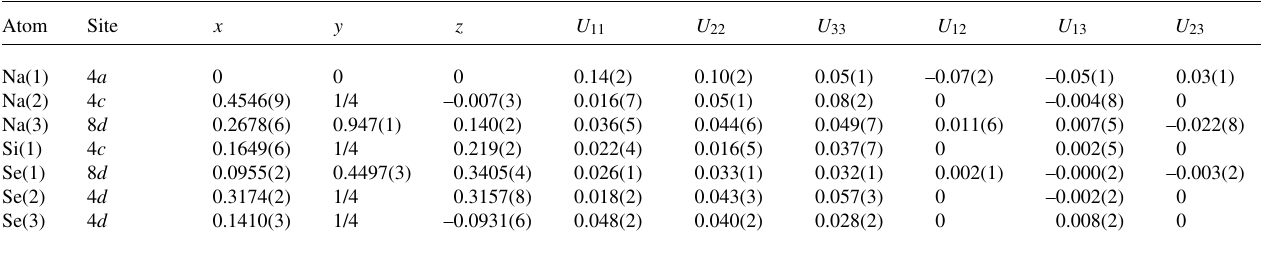
Table 2. Atomic coordinates and displacement parameters (in Å 2 )